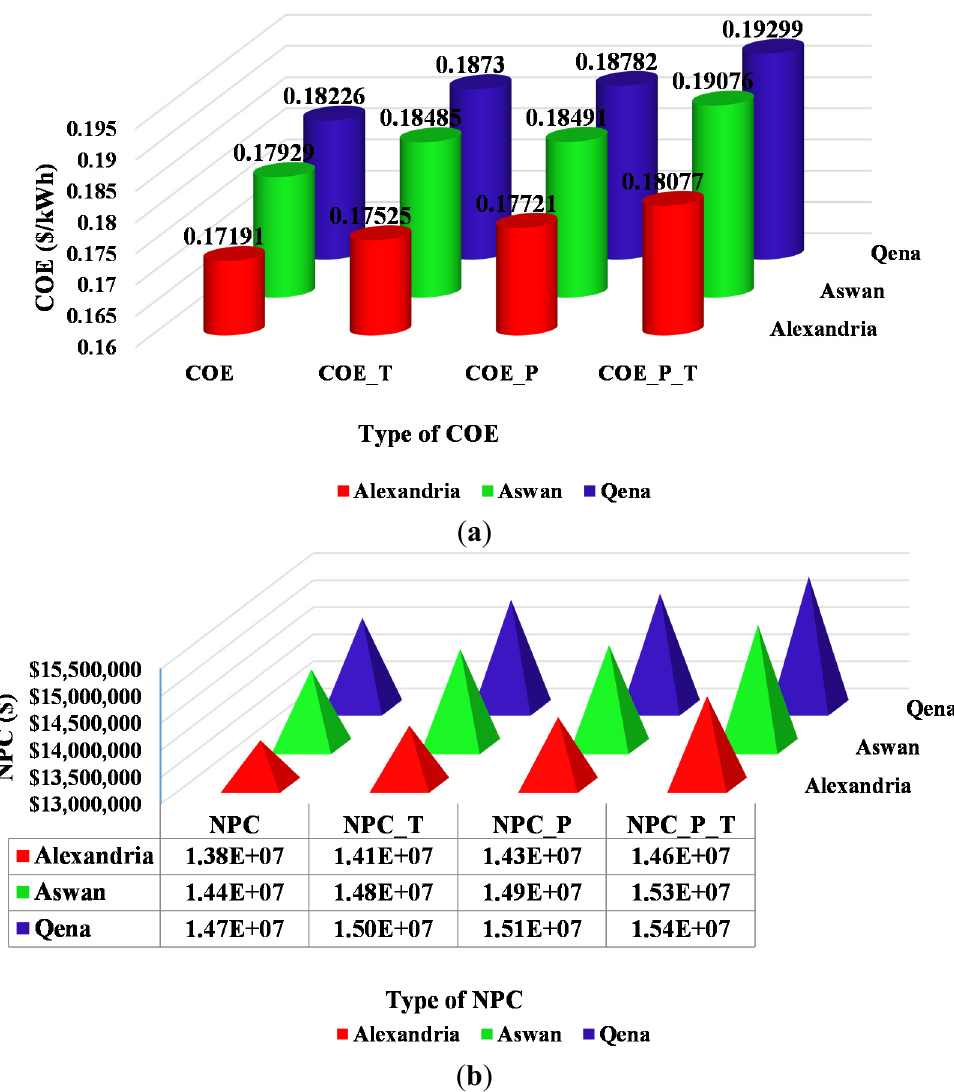
Figure 8. ( a ) The different COE of PV/wind/diesel/battery system in Alexandria, Aswan and Qena; ( b ) The different NPC of PV/wind/diesel/battery system in Alexandria, Aswan and